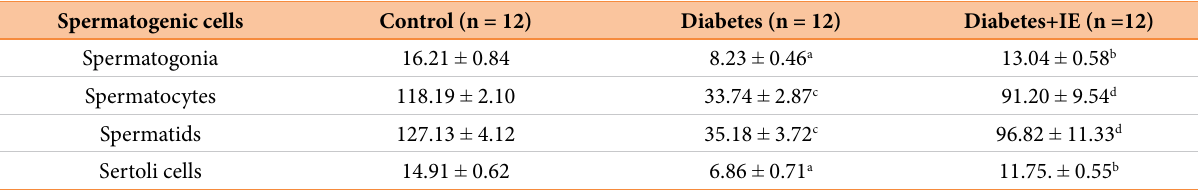
Figure 4 – Hematoxylin and eosin staining (H&E) (a-c), PCNA immune staining (d-f) and TUNEL assay results (g-i) of experimental groups. Table 4 – Counting of spermatogenic cells for each